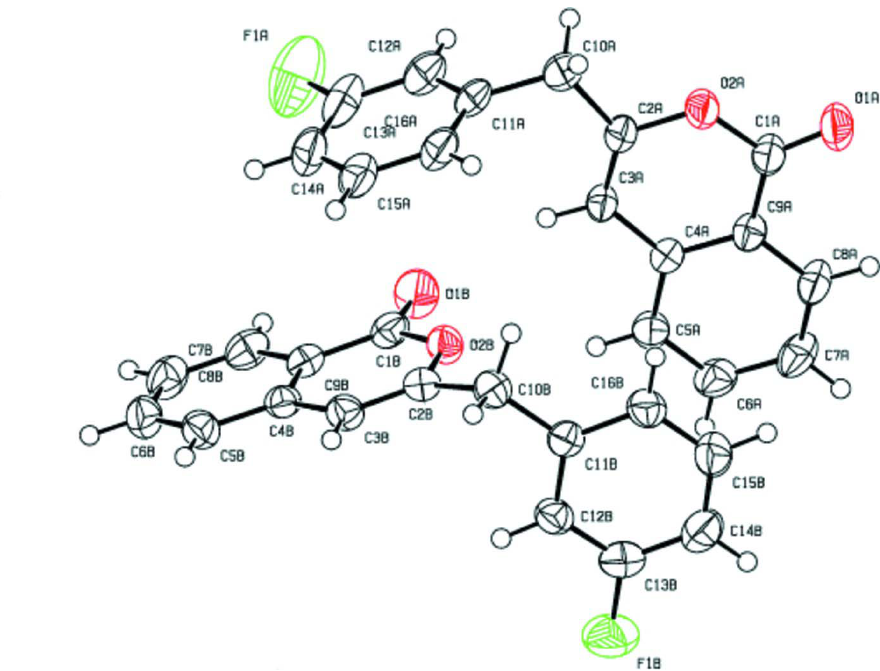
Figure 1 The molecular structure of the title molecule, with the atom-numbering scheme. Displacement ellipsoids are drawn at the 30% probability